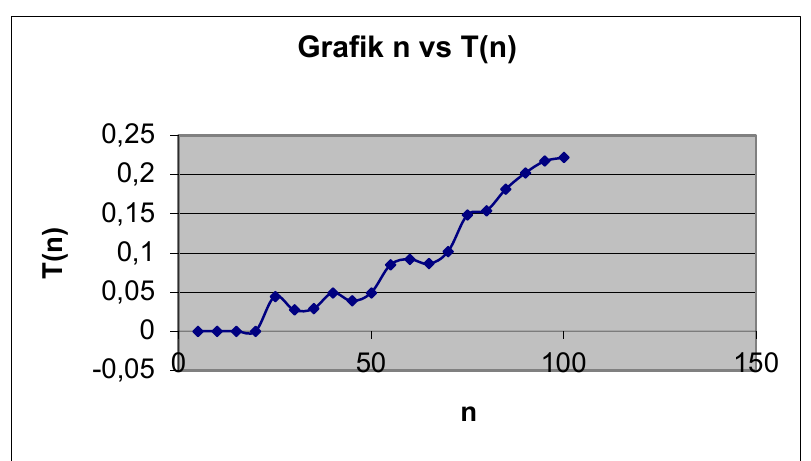
Figure 2. Graph of n vs T(n) in experiment I